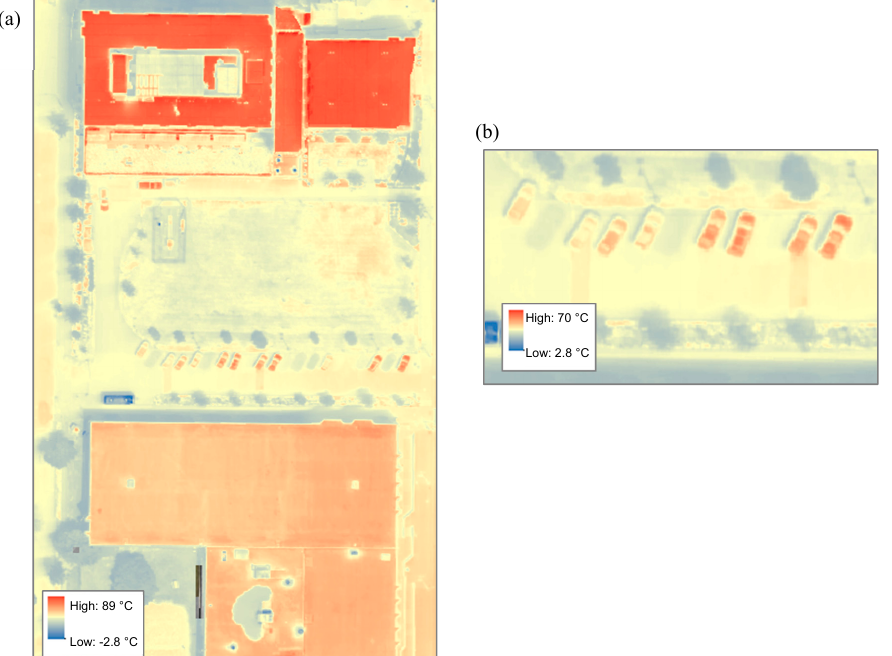
Figure 6. Spatial distribution of temperature from a flight recorded on 11 July 2018 ( a ) and zoomed in spatial distribution of temperature for the concrete parking lot from a flight recorded on 11 July 2018 ( b ). The hotter surfaces (red) in the right image are parked cars and the cooler surfaces (blue) are heat shadows visible after parked cars leave.